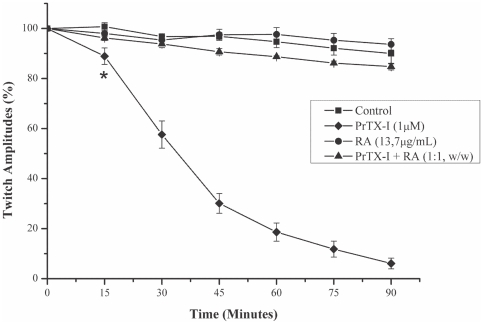
Effects of PrTX-I alone and PrTX-I pre-incubated with RA on indirectly evoked twitches in mouse phrenic-diaphragm preparations.The ordinate represents the percentage amplitude of twitches relative to the initial amplitude. The abscissa indicates the time after the addition of toxin to the organ bath. The points are the mean ± S.E. * indicates the point at which differences between PrTX-I and the control become significant.